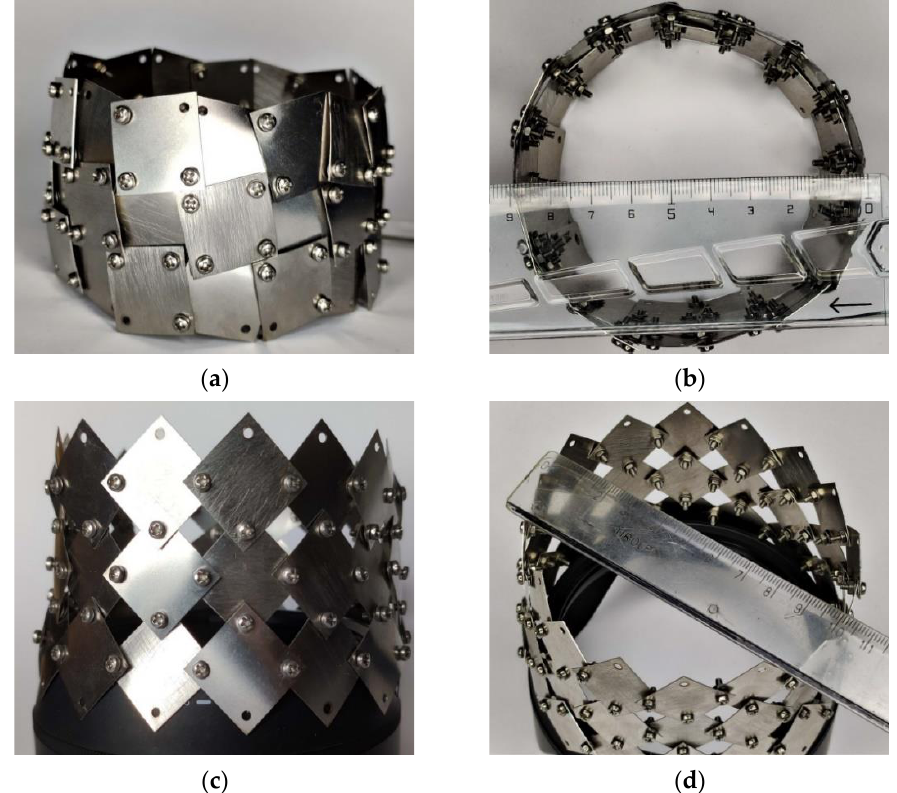
Figure 10. Photographs of auxetic structures in the form of a closed circle made of thin steel sheets in ‘ closed ’ ( a , b ) and ‘ open ’ positions ( c , d ).